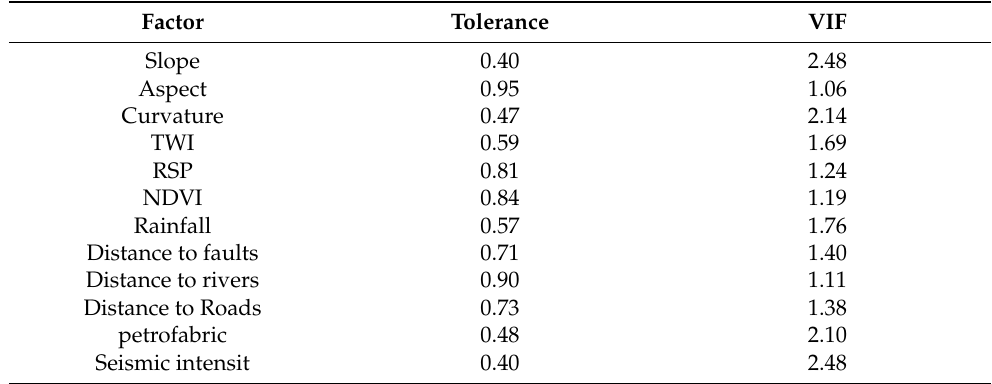
Table 1. Multicollinearity of